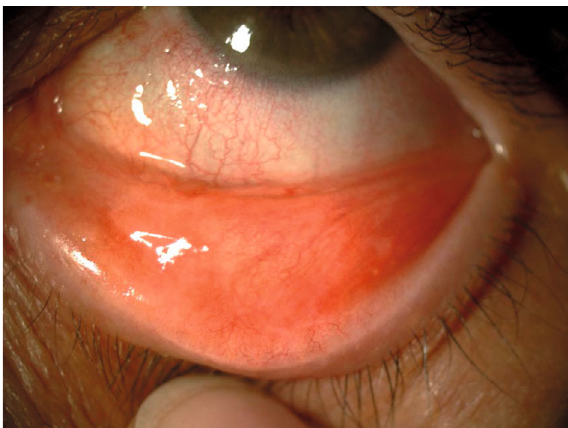
Figure 4: One month after the start of the treatment, the lesion has disappeared in the left